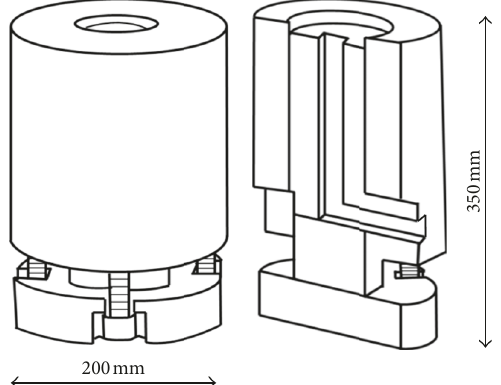
Figure 1: Schematic diagram and dimensions of the ECAP die.